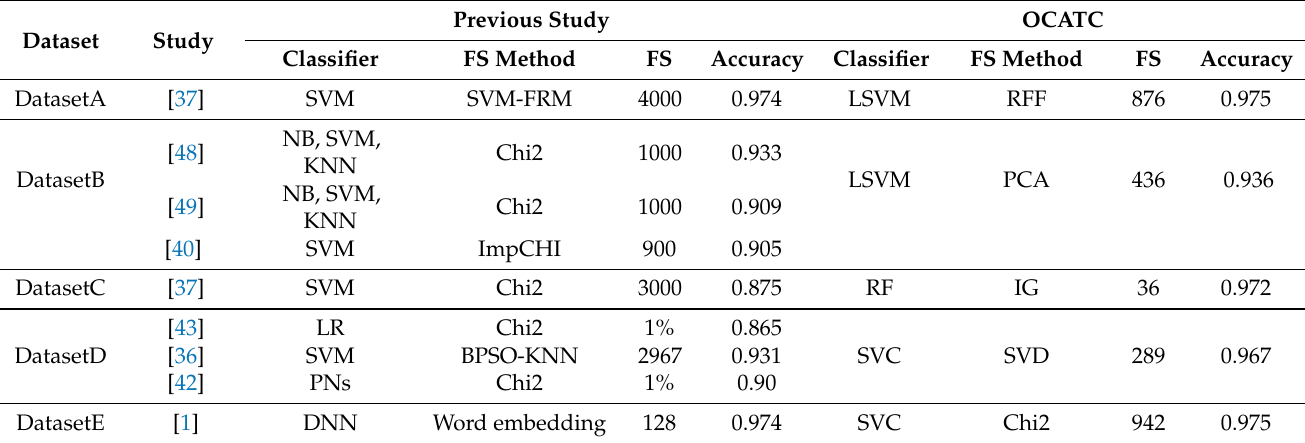
Table 6. OCATC results compared to state-of-the-art